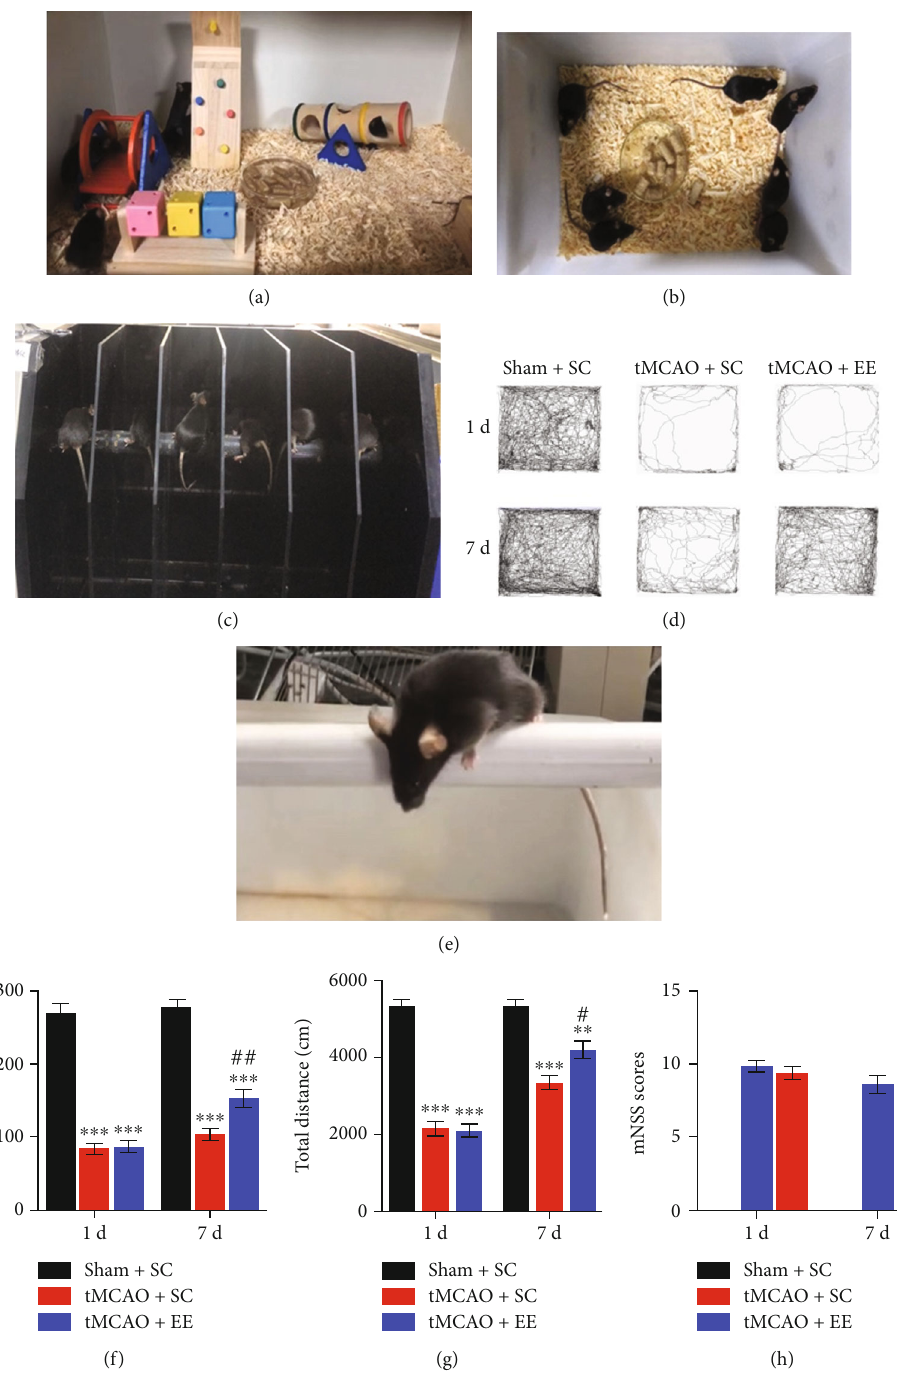
Figure 1: (a, b) Views of housing conditions. (a) Enriched environment (EE). (b) Standard condition (SC). (c – h) Behavioral tests, n = 6 . (c, e) The experimental pictures of the rotarod test and mNSS performances, respectively; (d) the trajectory chart of the open- fi eld test. (f – g) Statistical charts of behavioral tests. ∗∗ P < 0 : 01 and ∗∗∗ P < 0 : 001 vs . sham+SC group; # P < 0 : 05 and ## P < 0 : 01 vs . tMCAO+SC